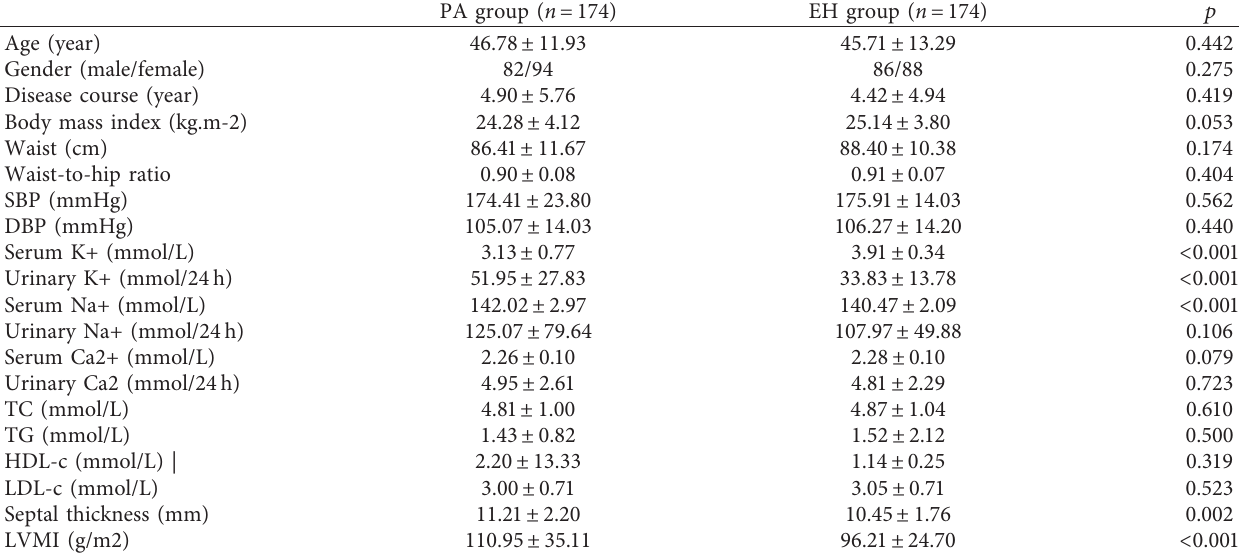
Table 1: The clinic features between PA and EH